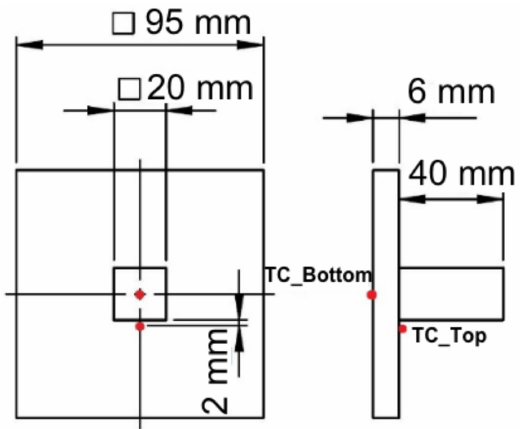
Figure 5. Structural dimensions for 3D solid structure and thermocouple